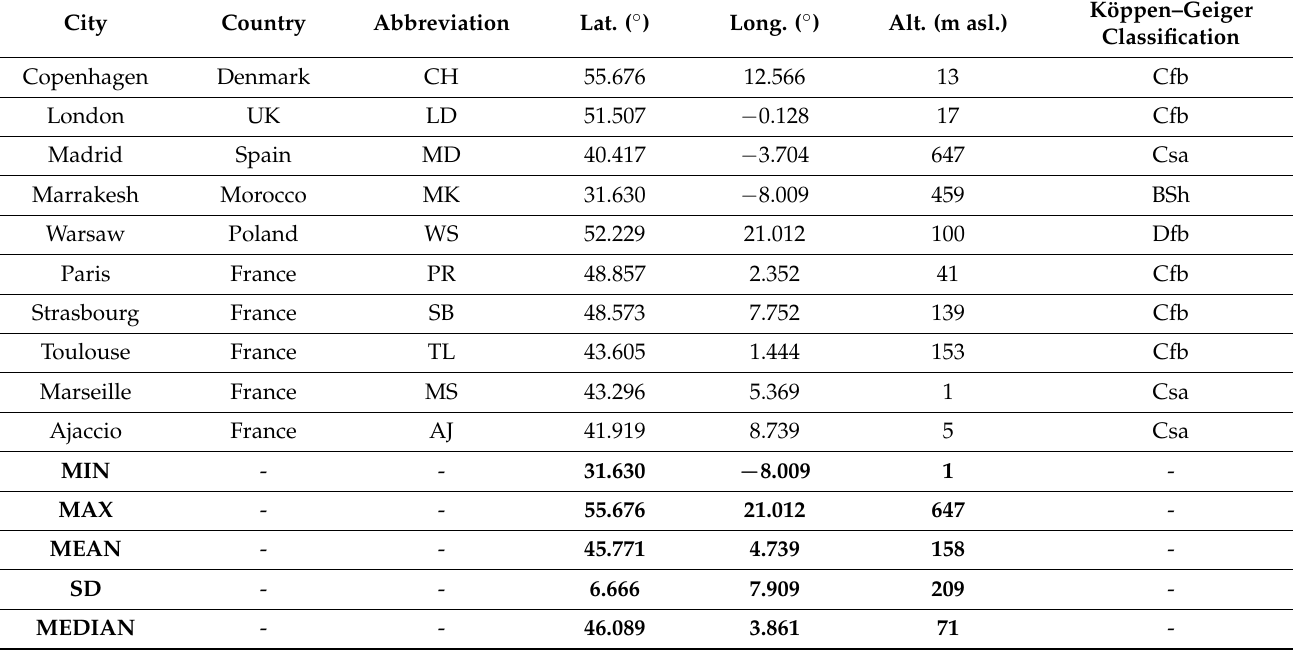
Table 1. Studied sites on each spatial scale for the determination of H 2